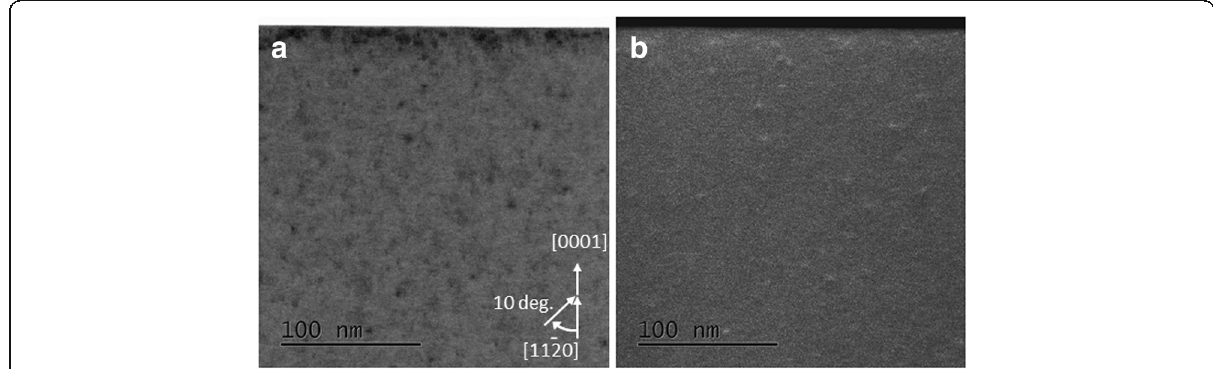
Fig. 6 Cross-sectional a STEM-BF and b STEM-ADF images of Mg-doped bulk GaN sample obtained in off-zone axis condition to strengthen the defects